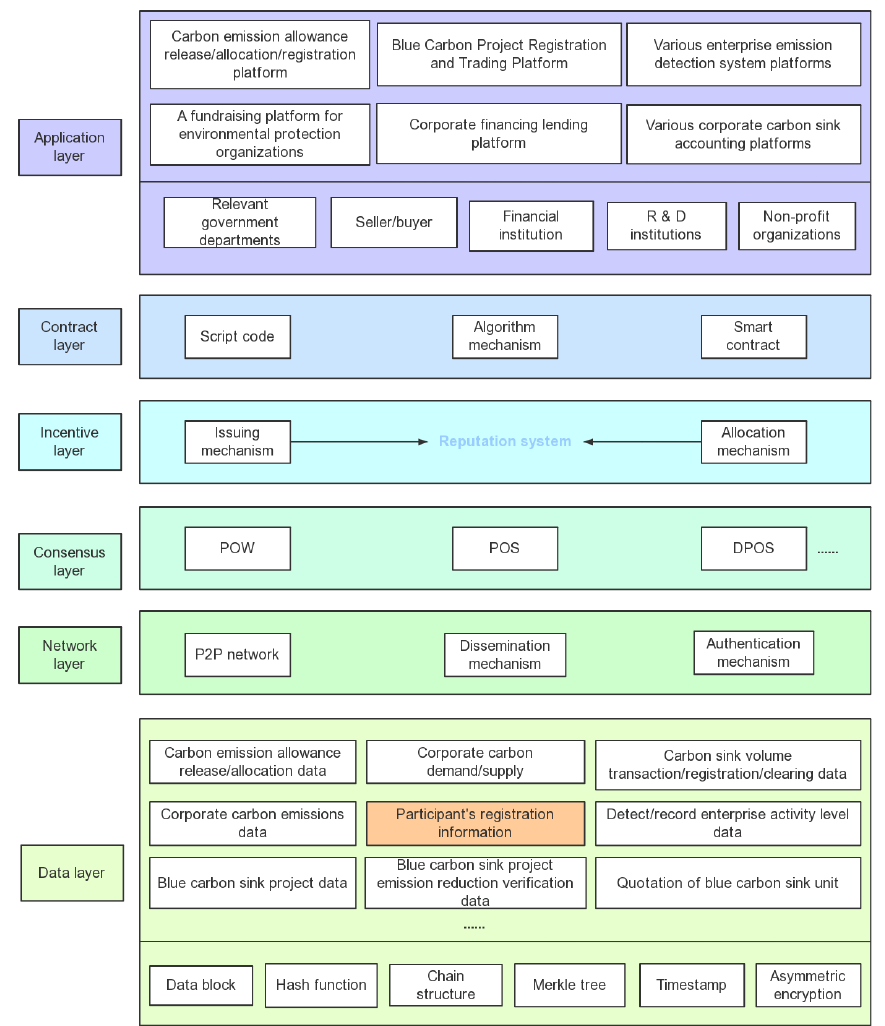
Figure 4. Blue carbon management application system architecture diagram. (Source: Designed by the authors).